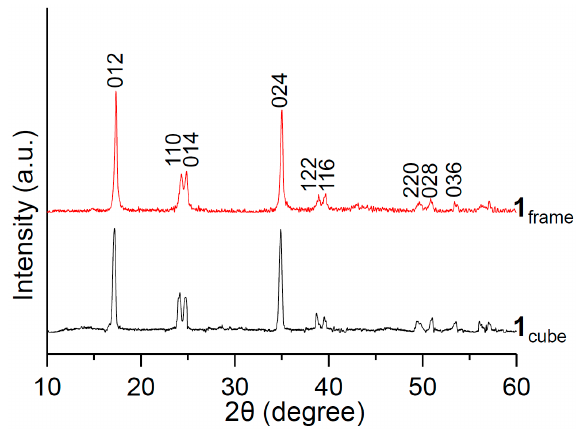
Figure 3. Powder X-ray diffraction (PXRD) patterns of 1 crystals.